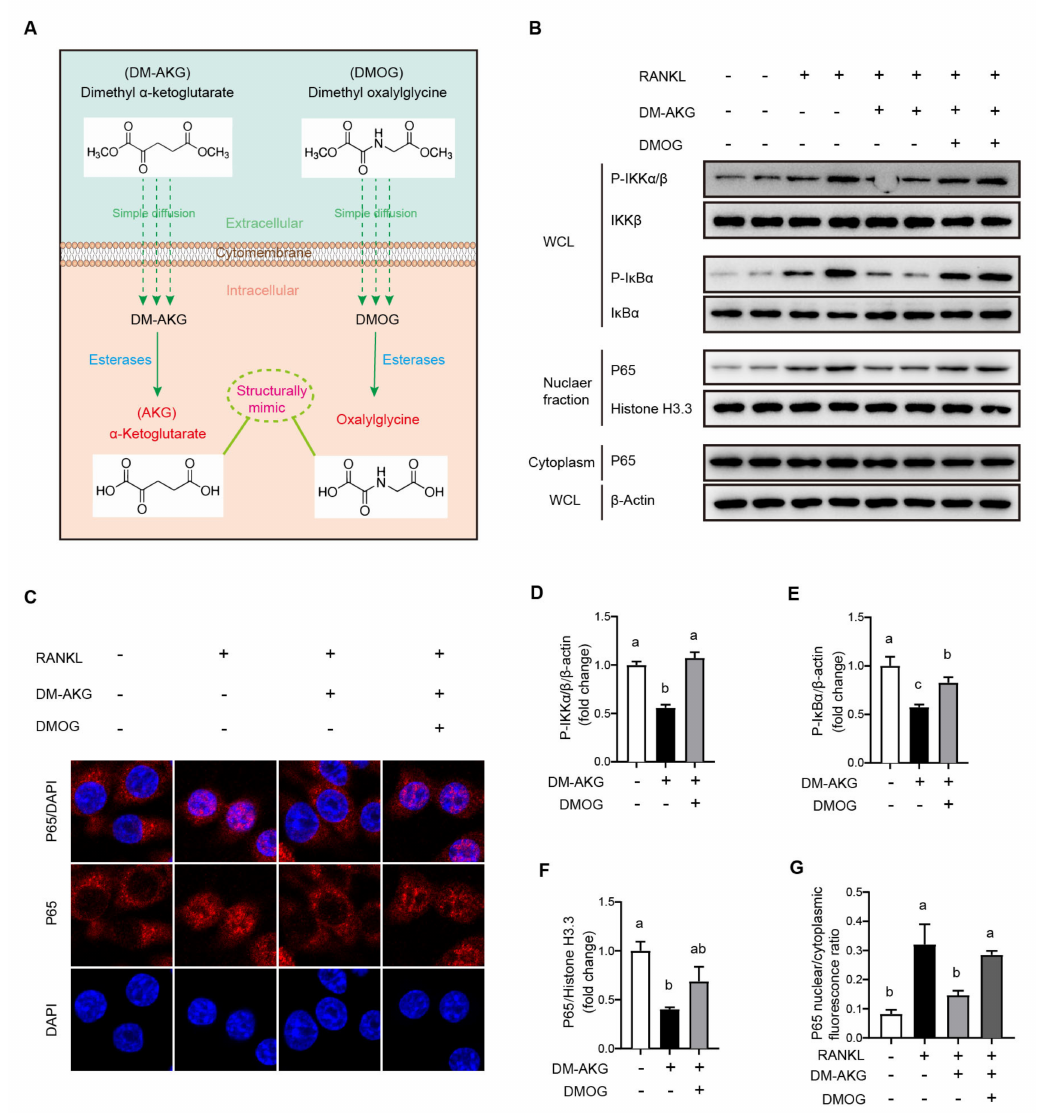
Figure 4. DMOG antagonizes the inhibitory effects of DM-AKG on the NF- κ B signaling pathway during osteoclast differentiation. ( A ) Schematic illustration of DMOG entering cells and further being cleaved to oxalylglycine to antagonize AKG. ( B ) Immunoblot analysis of nuclear and cytoplasm NF- κ B P65, phosphorylated (P-) IKK α / β , IKK β , phosphorylated (P-) I κ B α , and I κ B α in RAW264.7 incubated with DMOG (5 mM) for 2 h and then co-incubated with DM-AKG for 3 h (5 mM), followed by RANKL stimulation for 30 min. WCL, whole-cell lysate. ( C ) Representative images of immunoflu- orescence for P65 in RAW264.7 cells incubated with DMOG (5 mM) for 2 h and then co-incubated with DM-AKG for 3 h (5 mM) followed by RANKL stimulation for 30 min. WCL, whole-cell lysate. Quantification of immunoblot of ( D ) nuclear P65, ( E ) P-IKK α / β , and ( F ) P-I κ B α ( n = 3). ( G ) Quan- titative immunofluorescence results of P65 nuclear translation ( n = 3). All data were presented as means ± SEM. No matching letters between the two groups point to a significant